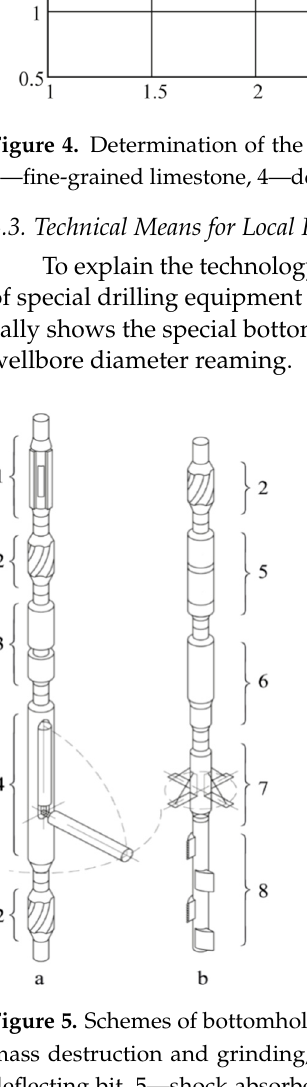
Figure 4. Determination of the circular recess drilling interval: 1—siltstone, 2—stone sandstone, 3— fine-grained limestone, 4—dolomite.